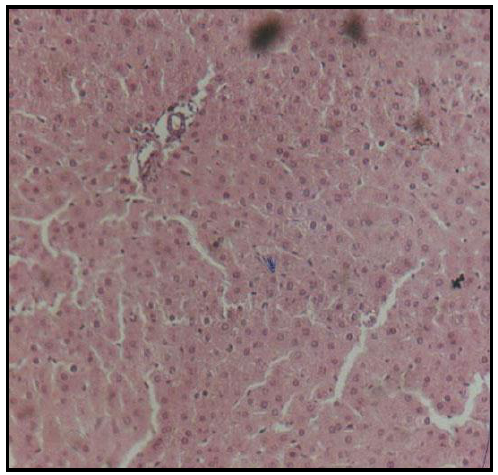
Figure(1):section showing normal rat's liver Magnification: (10*10) ; staining: Haematoxylline and Eosin.